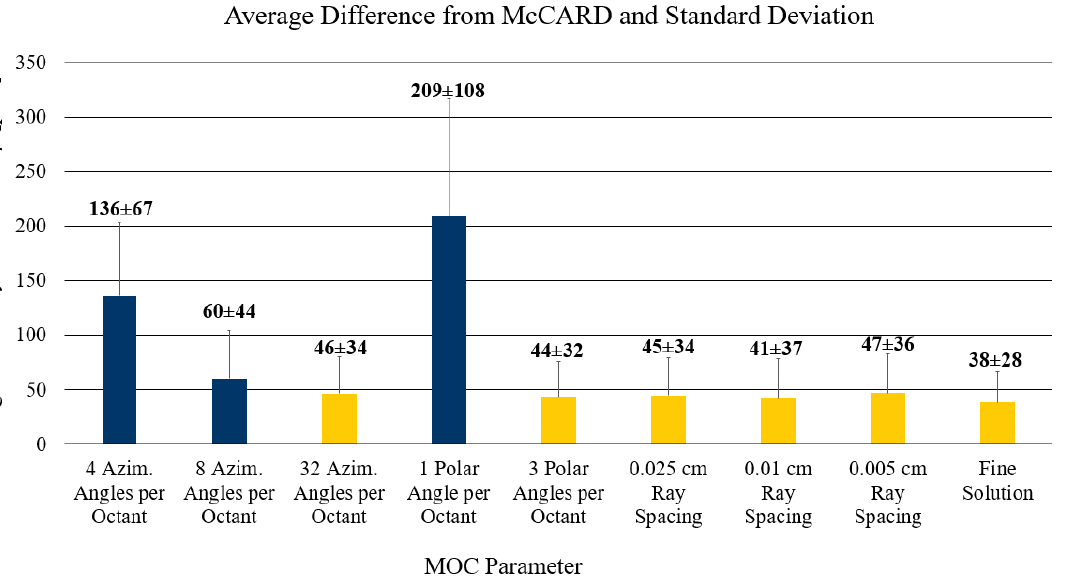
Figure 9. Average difference from McCARD k inf and standard deviation for single pin MOC